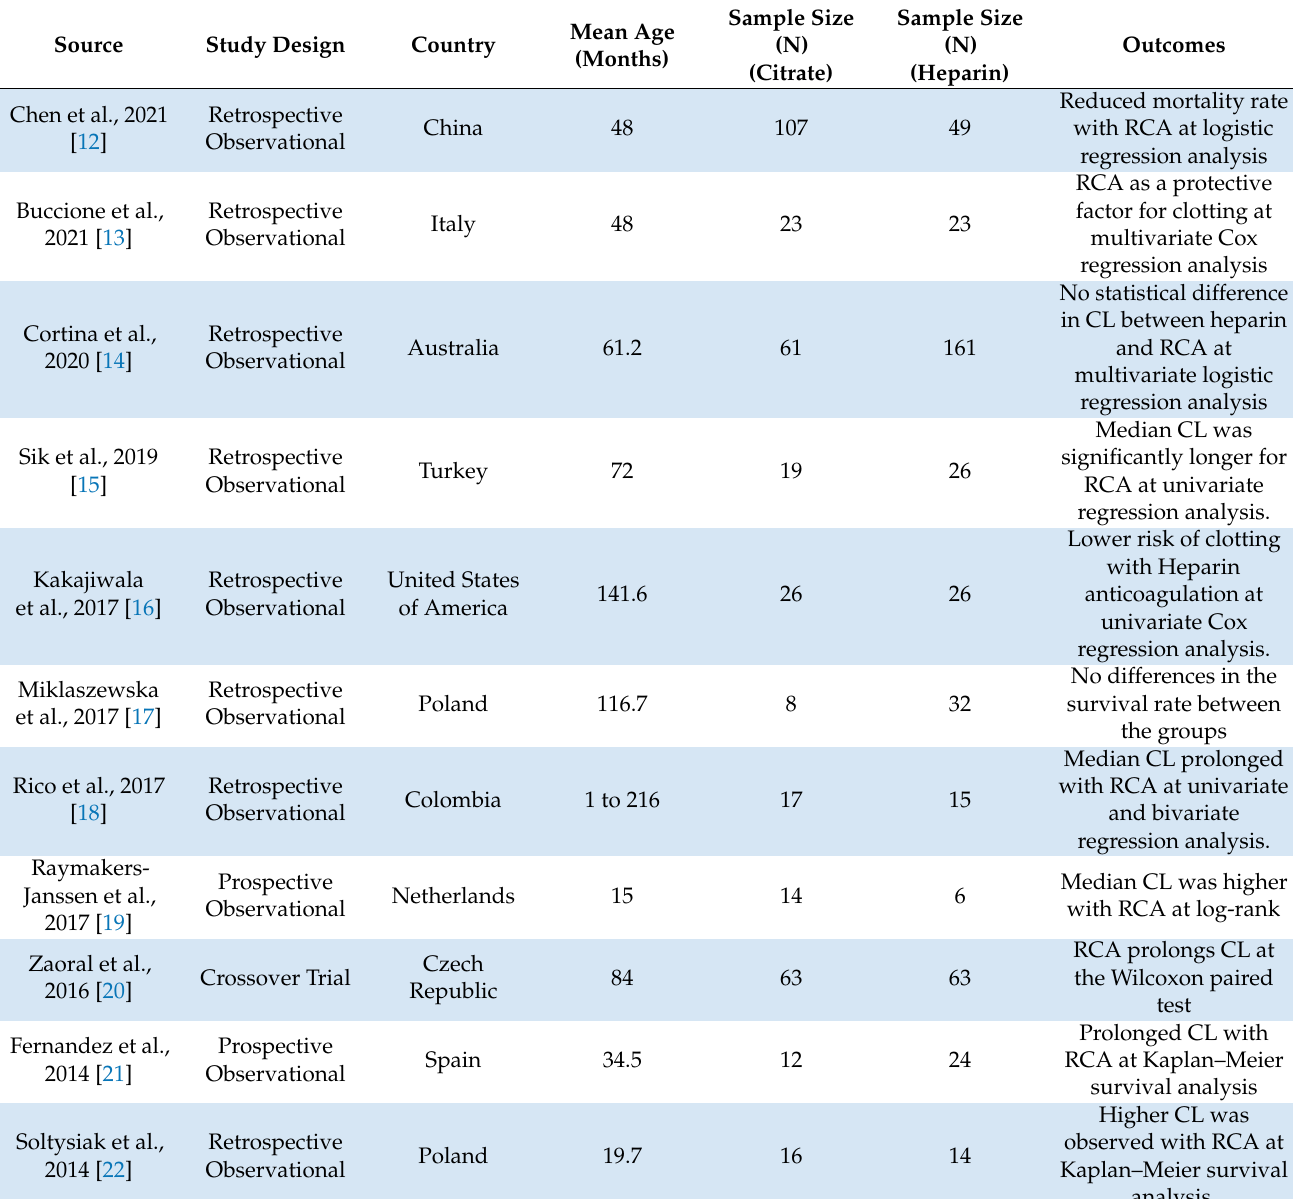
Table 2. Characteristics of studies included. Abbreviations: RCA, regional citrate anticoagulation; CL, circuit life.